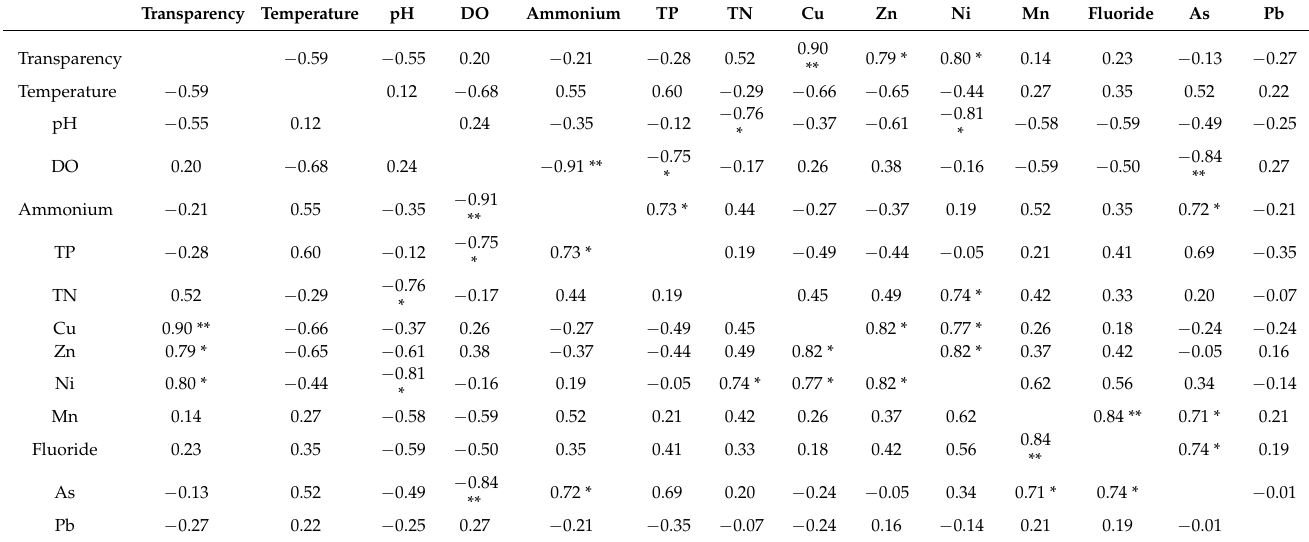
Table 2. Pearson’s correlation matrix for the chemical and physical properties of the water samples (* p value < 0.05; ** p value <